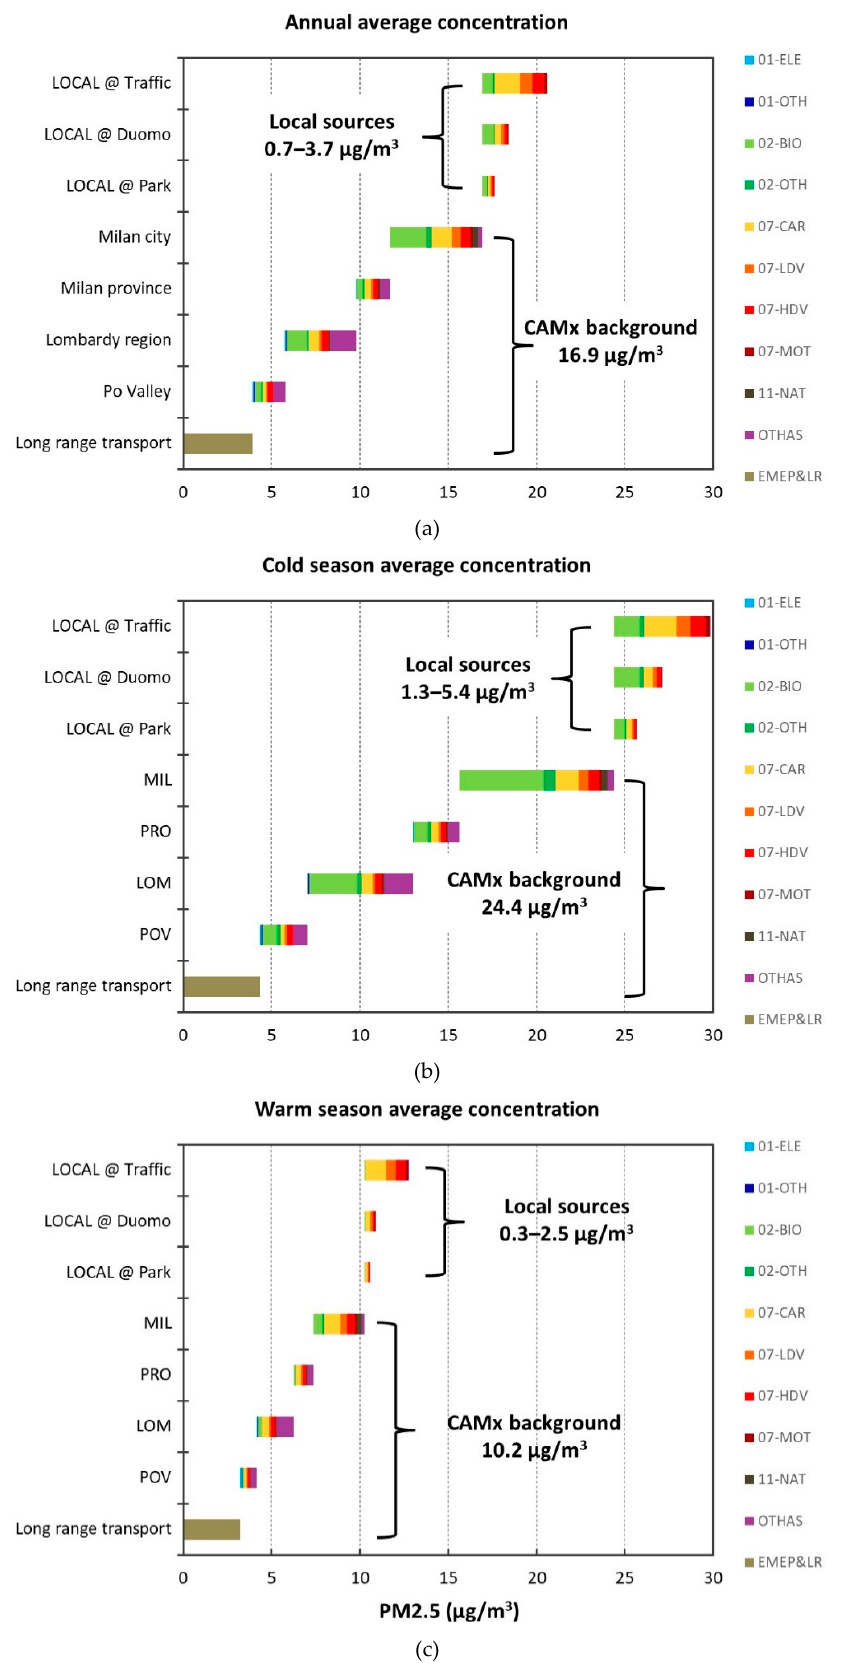
Figure 8. PM2.5 source apportionment by HMS for PARK, DUOMO, and TRAFFIC receptors for annual average ( a ), cold season average ( b ), warm season average concentration ( c ).